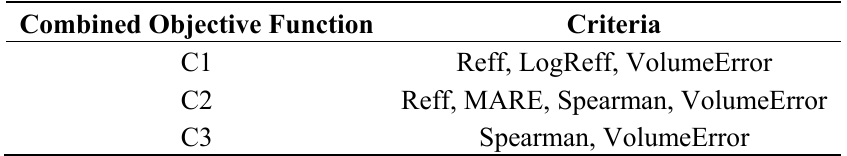
Table 4. The three combination objective functions used during the Genetic Algorithm and Powell optimization (GAP) calibrations within HBV-light. The criteria were weighted equally in each case. See Table 3 for a more detailed specification of each of the